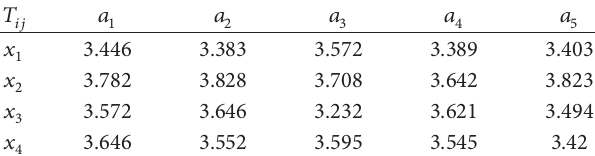
Table 5: 𝑇(𝛾 𝑖𝑗 ) under every attribute.